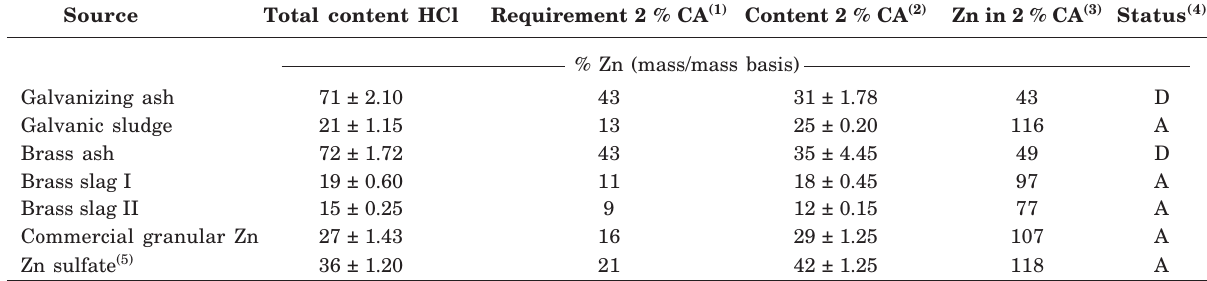
Table 4. Solubility level required by MAPA and observed for Zn sources using the official 2 nd extractor 2 % citric acid (2 % CA)